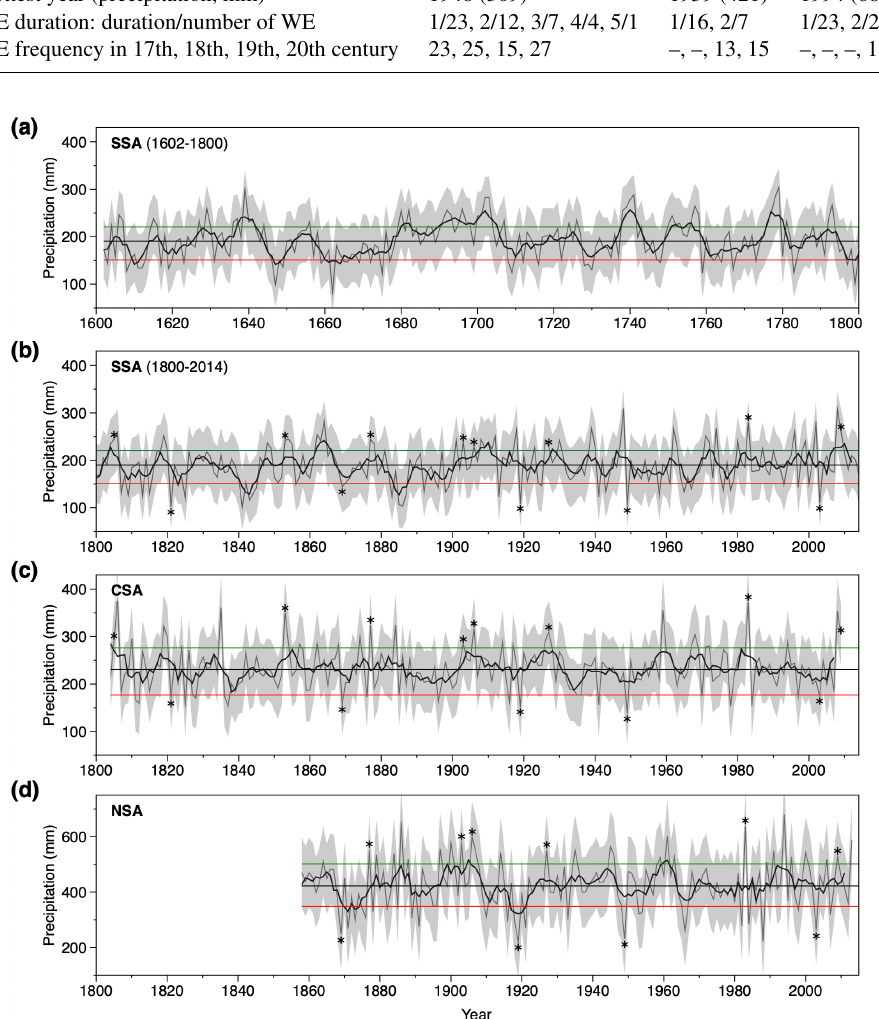
Figure 6. Extreme wet and dry years for SSA (a) , CSA (b) and NSA (c) . Gray lines indicate reconstructed precipitation values, and bold black lines are the 5-year moving average; horizontal solid black lines are mean values of the instrumental data; red and green dashed horizontal lines are empirical thresholds of the 25th and 75th percentile of the instrumental data, respectively. Uncertainty bands (gray areas) are estimated as twice the standard error of prediction ( ± 2 σ ). Asterisks indicates common extreme wet and dry years for all three reconstructions; common period from